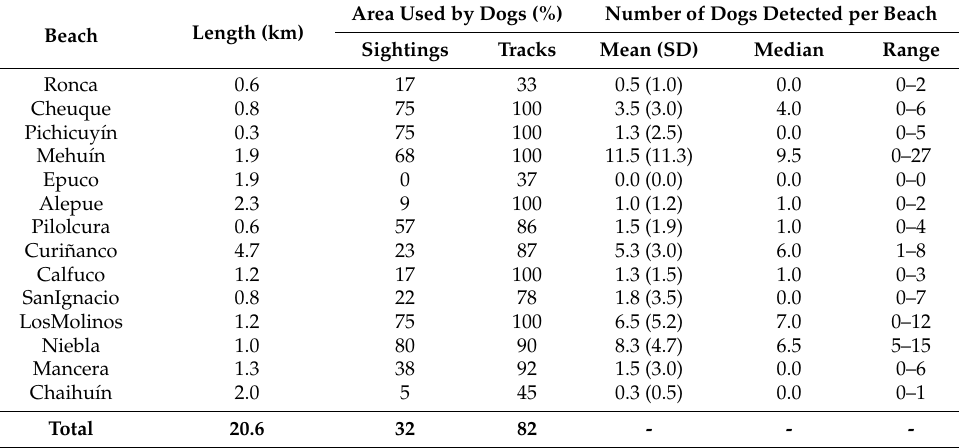
Table 1. Presence and abundance of dogs at sandy beaches of Los R í os region, southern Chile. The table shows the length of the beach, area used by dogs (percentage of the segments where dogs were sighted or their tracks detected on at least one occasion), the mean number of dogs detected and its standard deviation (SD), the median, and the minimum and maximum number of dogs detected on the beach (Range). Totals correspond to the sum of the extension of the beaches sampled and the proportion of the segments where dogs were detected at least once. We did not include the total for number of dogs to prevent double counting. Area Used by Dogs (%) Number of Dogs Detected per Beach Length (km)